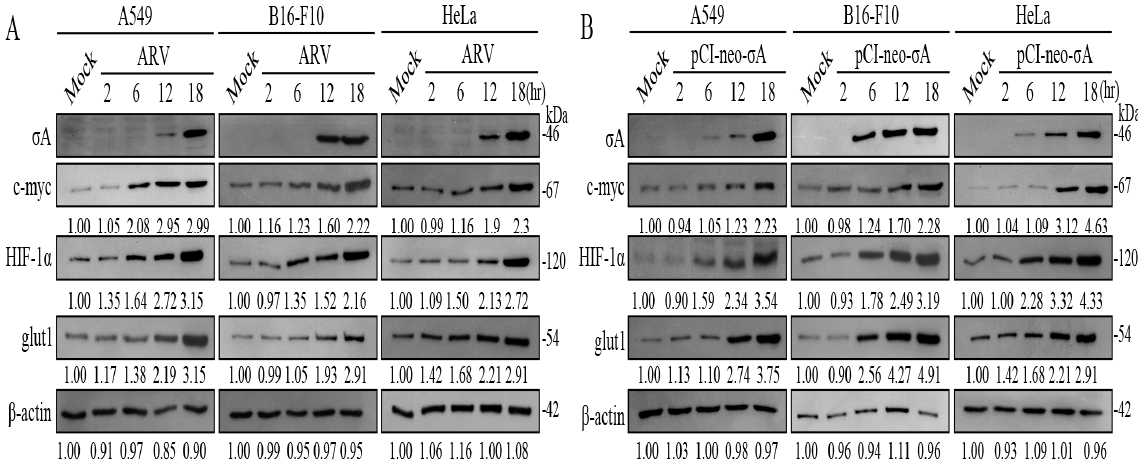
Figure 2. ARV infection and σ A transfection increased of c-myc, HIF-1 α , and glut1 in cancer cell lines. ( A ) A549, B16-F10, and HeLa cancer cell lines were infected with ARV at an MOI of 10. Cell lysates were collected with 2.5× sample buffer dye at 2, 6, 12, and 18 h post-infection for Western blots. ( B ) Cancer cell lines were transfected with the pCI-neo- σ A plasmid at 2, 6, 12, and 18 h. Cell lysates were collected with 2.5× sample buffer dye and examined using Western blots. Signals in all Western blots were quantified with Image J and normalized to β -actin as shown in Supplementary Figure S2.